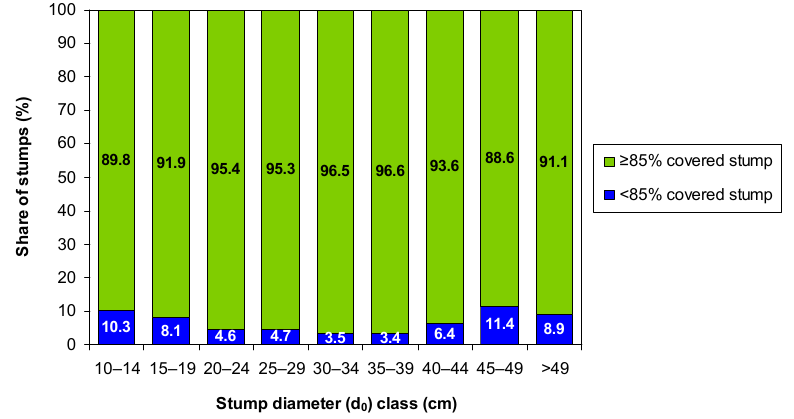
Figure 7. The shares of <85% and ≥ 85% covered stumps inventoried by stump diameter class.